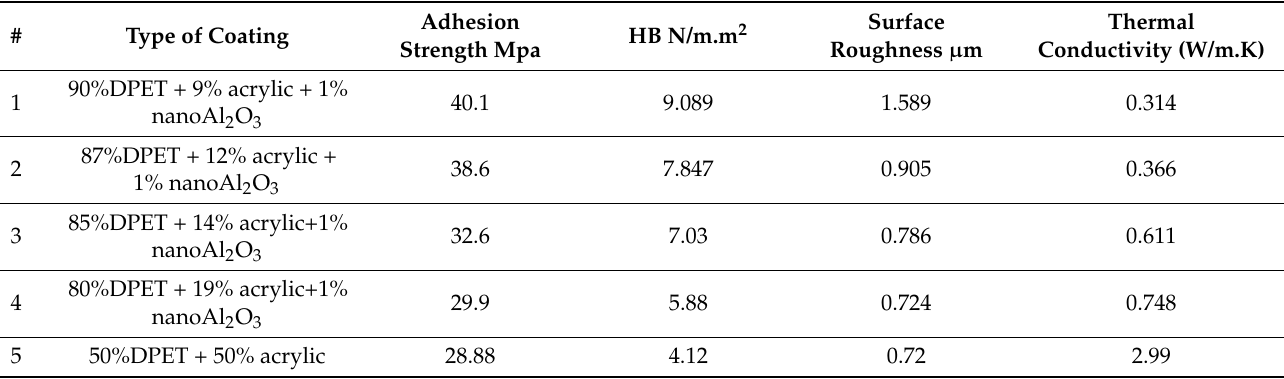
Table 1. The optimum mechanical and thermal